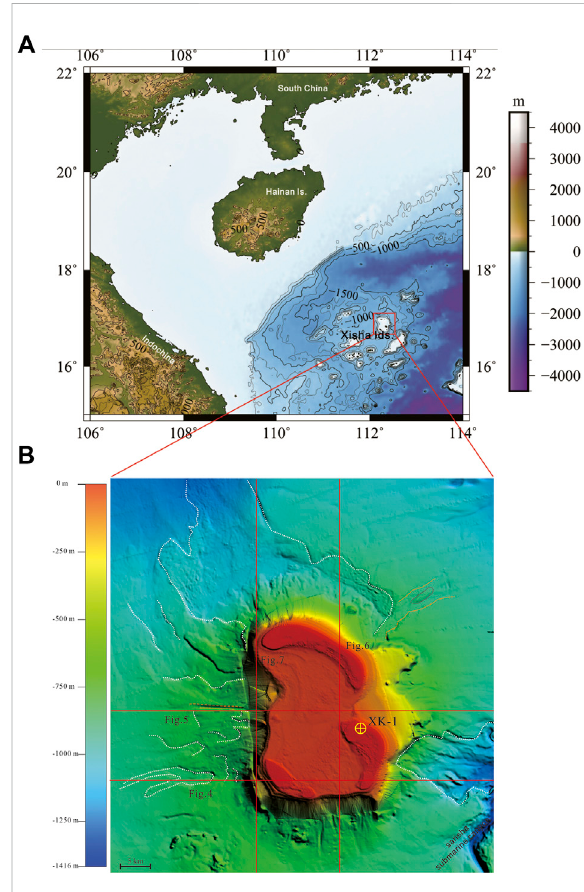
Geomorphology and seismic line location. (A) Bathymetric map of the northern South China Sea. (B) Bathymetric map of Xuande Atoll. Water depths in the reef fl at were measured using a single-beam system, while the deepwater data were obtained using a multi-beam system. Red lines: multi-channel seismic (MCS) survey lines; circles: drilled